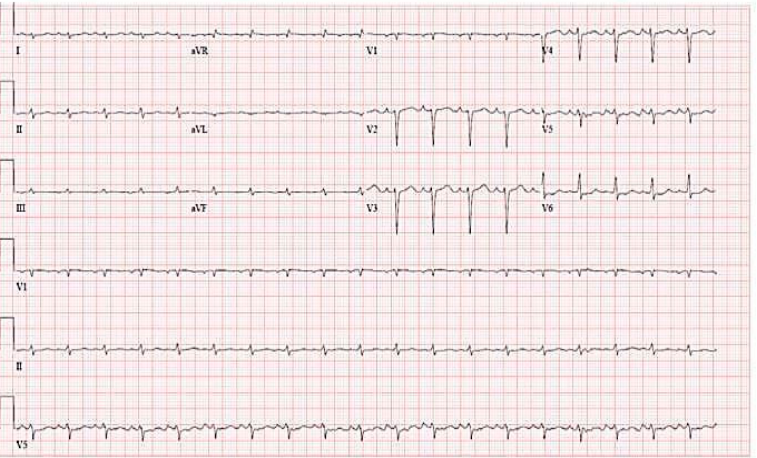
Figure 2. ECG of a patient with cardiac AL amyloidosis showing the pseudoinfarction pattern in anterior leads and small QRS voltages predominantly in the limb leads.